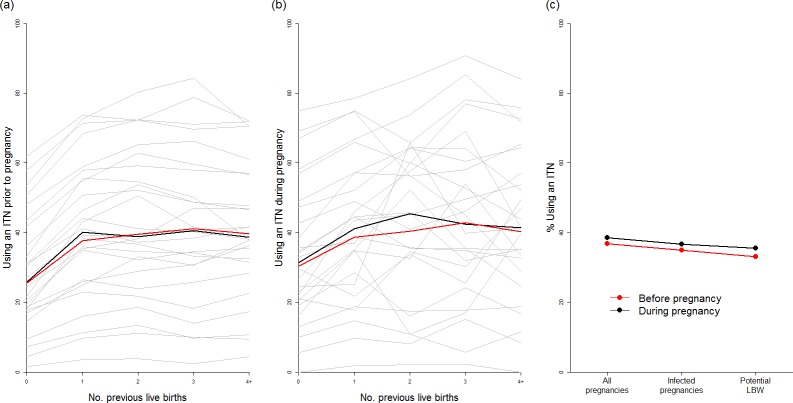
Usage of insecticide-treated nets in pregnancy.ITN usage prior to pregnancy (A) and during pregnancy (B) by parity (based on use during night preceding interview and weighted by age to reflect fertility patterns). Grey lines show usage estimates from each of the 26 country-level surveys with sufficient data, black lines show the median estimate of usage across surveys, and red lines show the estimate weighted by country population size, incorporating pixel-level urban and rural patterns. (C) Estimate of ITN usage weighted by population size within all pregnancies, within potentially infected pregnancies, and within pregnancies potentially leading to LBW. ITN, insecticide-treated net; LBW, low birthweight.